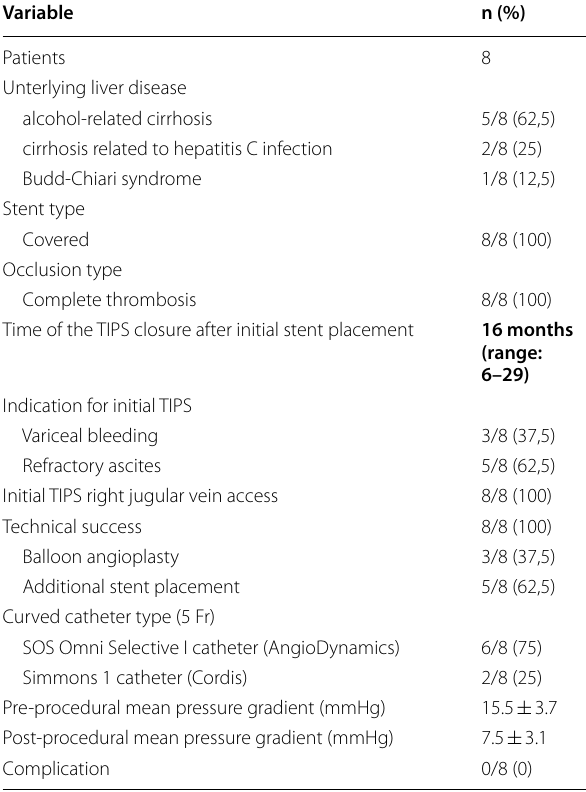
be performed depending on the underlying pathol- Table 1 Patient demographics and procedural details (Optional)